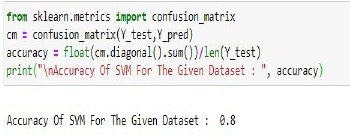
Figure 14. Accuracy of svm algorithm for semiconductor man- ufacturing